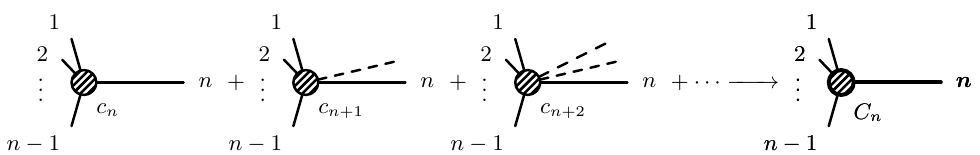
Figure 1 . The different terms in the v/ Λ expansion of the LE contact-term coefficient C n are generated by HE contact terms with additional soft Higgs legs (some c n ’s may vanish because of gauge